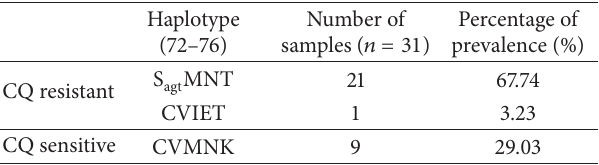
Table 3: Prevalence of pfcrt